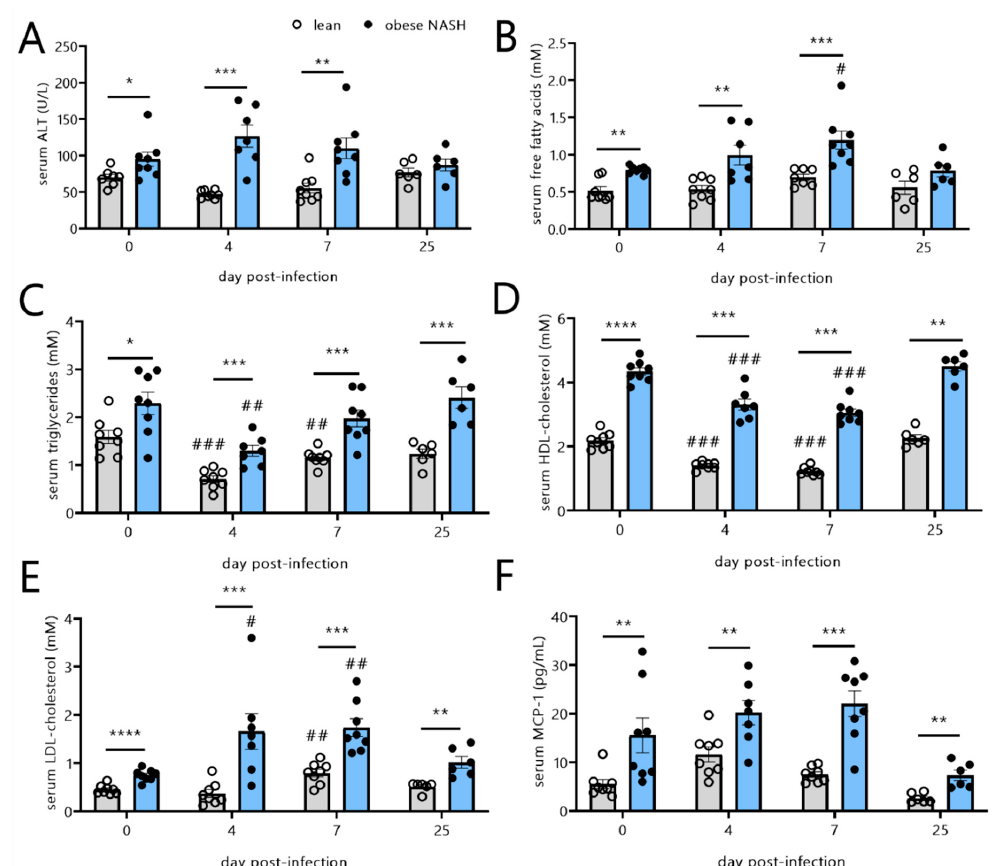
Figure 3. Effects of SARS-CoV-2 infection on serum variables in lean hamsters vs. obese NASH hamsters. Blood from the mock-infected and SARS-CoV-2-infected hamsters was collected at different timepoints post-infection. Serum levels of ( A ) ALT, ( B ) free fatty acids, ( C ) triglycerides, ( D ) HDL cholesterol, ( E ) LDL cholesterol, and ( F ) MCP-1 on dpi 4, 7, and 25 are shown. The data are expressed as the mean ± SD (n = 6–8 animals/group). Significant differences between lean hamsters and obese NASH hamsters were determined using the Mann–Whitney U test (* p < 0.05; ** p < 0.01, *** p < 0.001, **** p < 0.0001). The effect of SARS-CoV-2 infection is also depicted. The values were compared with those of mock-infected animals using a Kruskal–Wallis test and Dunn’s post-test (# p < 0.05, ## p < 0.01, and ### p < 0.001).